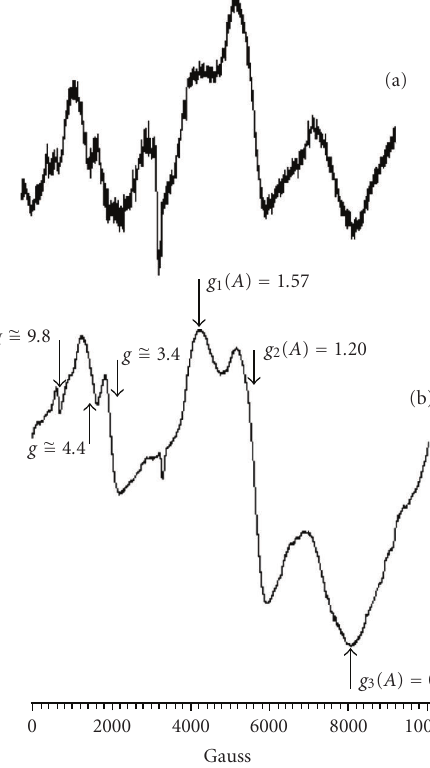
Figure 2: EPR spectra recorded at 4.2 K of (a) Ce-doped SG (Ce : Si molar ratio 1 · 10 − 3 ) inverted opals and (b) monolithic Ce-doped SG (Ce : Si molar ratio 1 · 10 − 3 ) prepared by sol-gel method